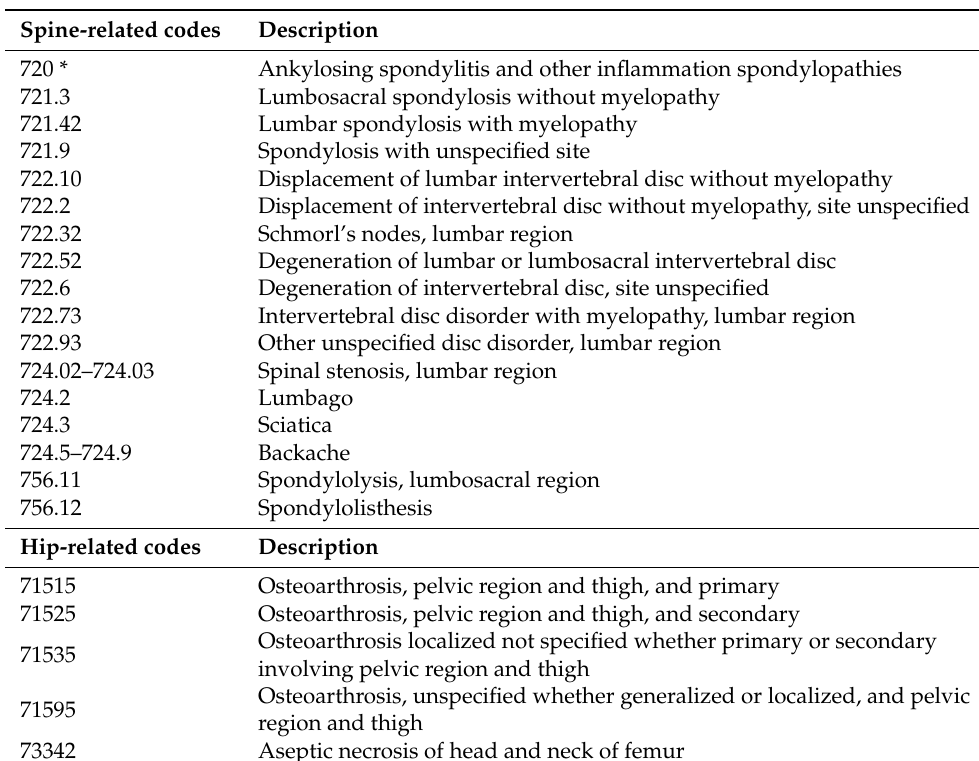
Table A3. Lumbar spine- and hip-related ICD-9 diagnosis